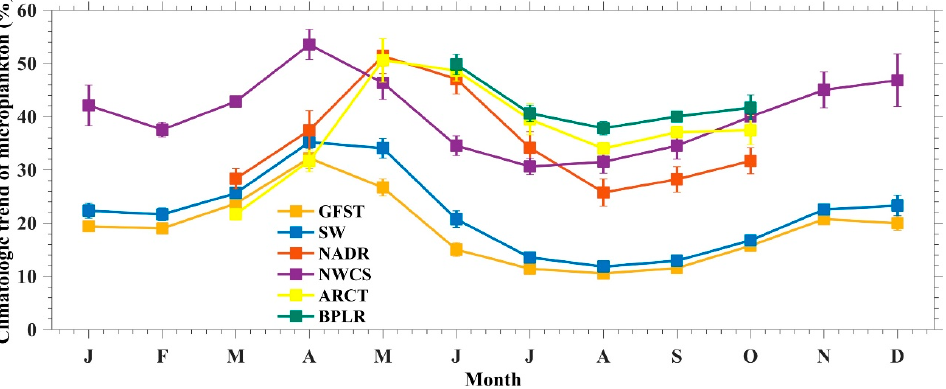
Figure 10. Climatological variation of microphytoplankton in the six ecological provinces.